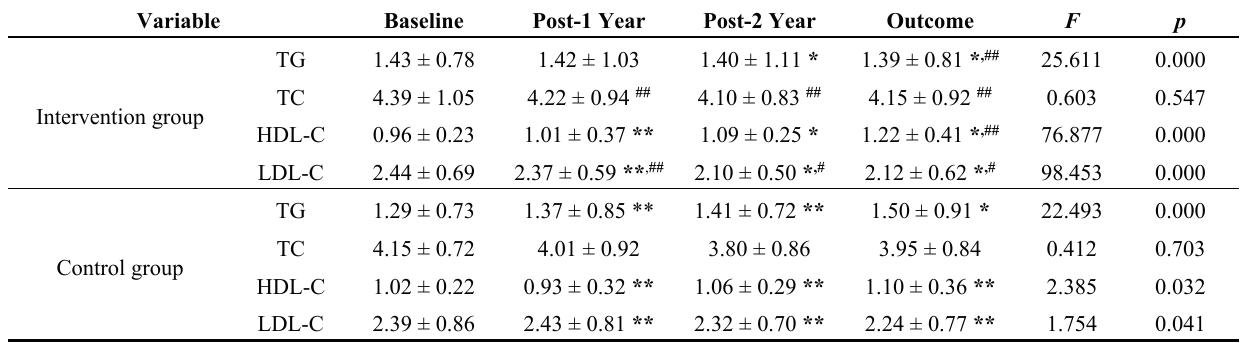
Table 2. Comparison of the survey population lipid levels at different time